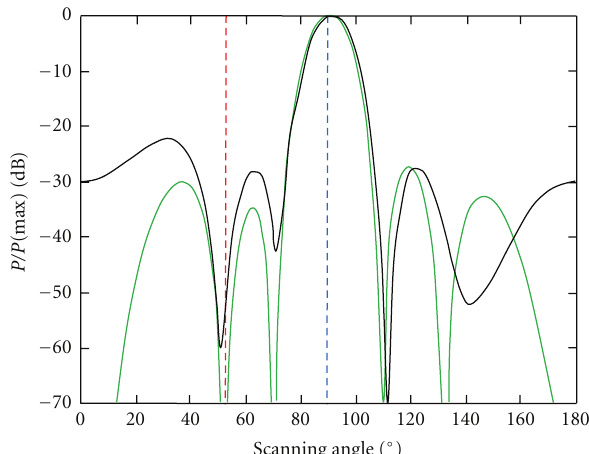
Figure 9: The ANN beam pattern received with 16 neurons in the hidden layer—the beam pattern setting to zero on the interference direction.